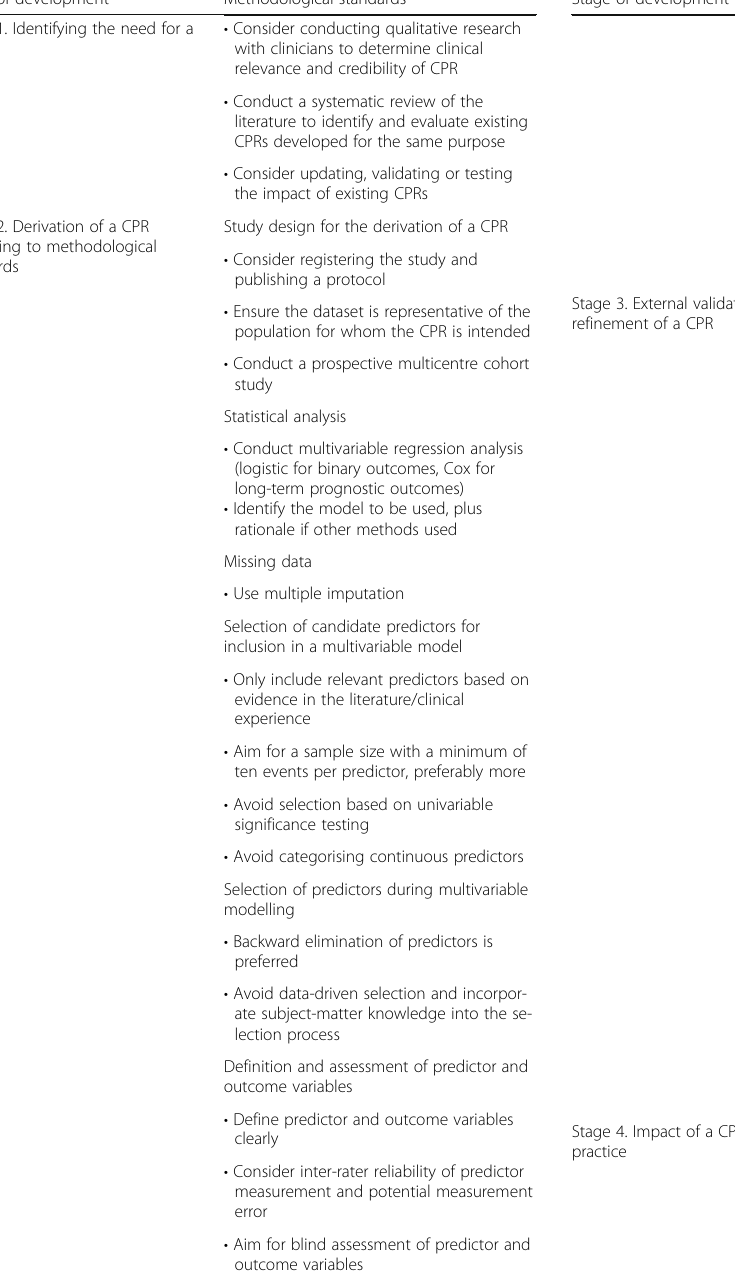
Table 1 Stages in the development and evaluation of clinical